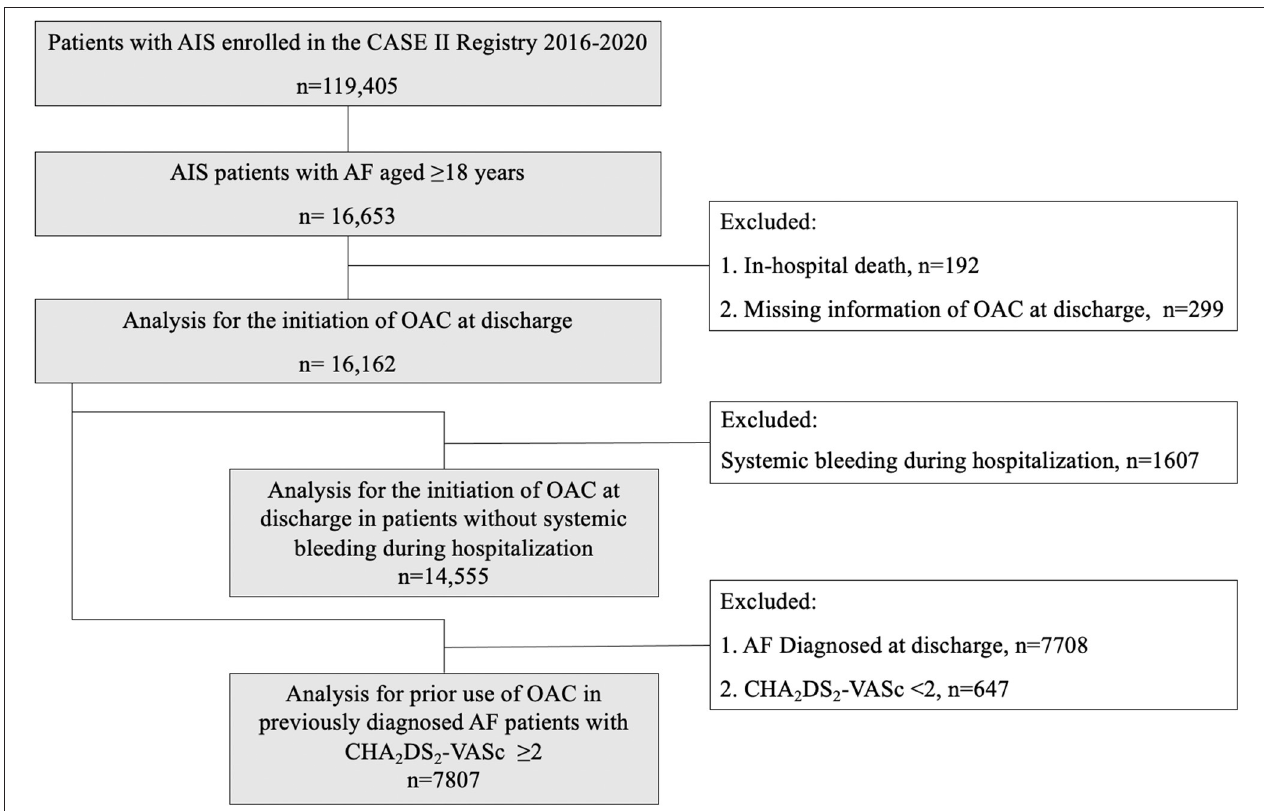
FIGURE 1 | Flow chart of study population identification. AIS indicates acute ischemic stroke; AF, atrial fibrillation; CASE II, Computer-based Online Database of Acute Stroke Patients for Stroke Management Quality Evaluation; OAC, oral